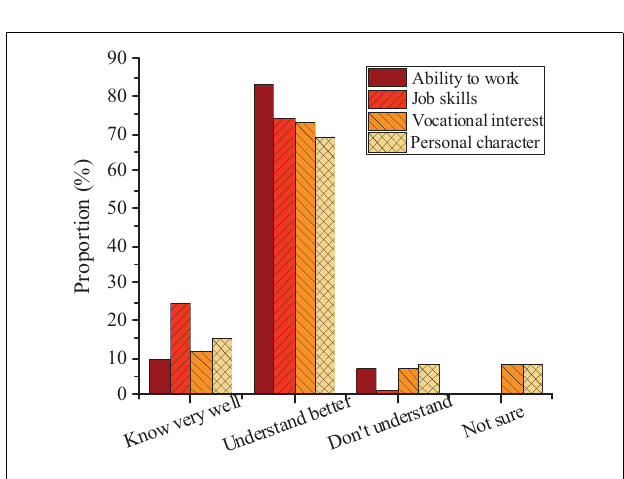
FIGURE 6 | Knowledge-based employees’ understanding of their own situation in the enterprise M.